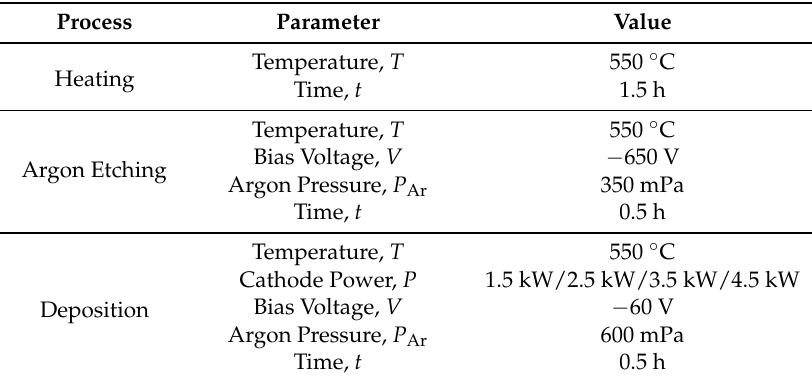
Table 1. Deposition parameters of the Cr 2 AlC